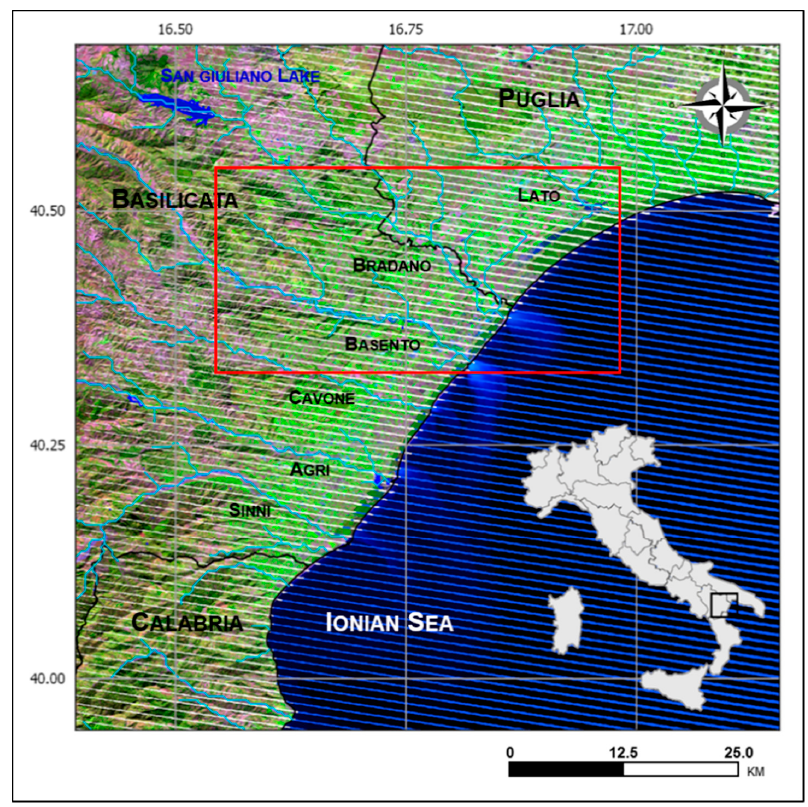
Figure 1. Localization of the Region of Interest (ROI). In the background, the Landsat Enhanced Thematic Mapper Plus (Landsat 7 ETM+) false-color (R = Short Wave InfraRed-SWIR; G = NIR; B = RED) composite image of 5 December 2013 at 9:31 GMT. The red box is the area used in the text.